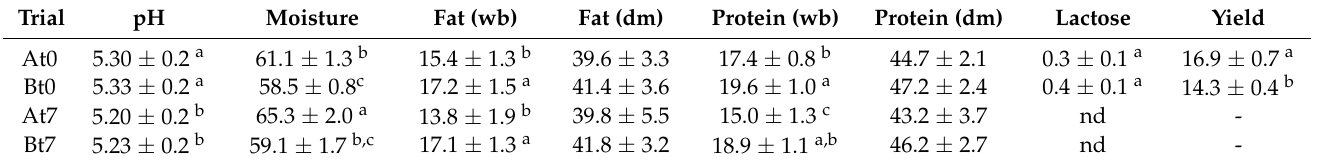
Table 1. Gross composition (%, except for pH, ± standard deviation) of the cheese samples from trials A and B at 0 and 7 days refrigerated storage. Values in the same column bearing different superscripts are different at p < 0.05; wb = on wet basis; dm = on dry matter; nd = not detected (below detection limit).